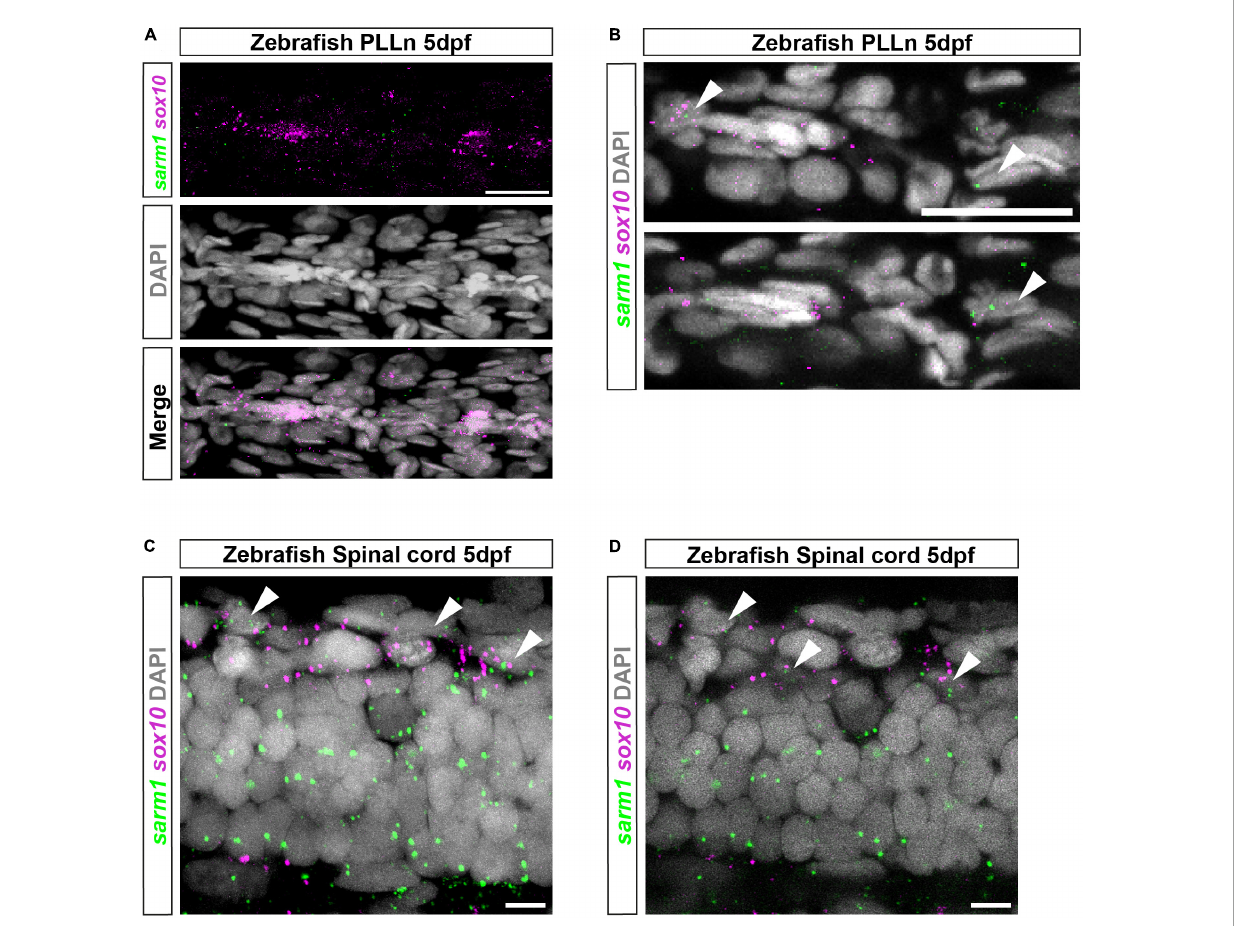
FIGURE2 sarm1 expression in zebrafish larvae PLLn and spinal cord. (A) MAX projection, lateral view of PLLn of a 5dpf larva demonstrating HCR in situ labeling for sox10 and sarm1 mRNA and DAPI staining to mark nuclei. (B) Single confocal z plane, 616 nm optical thickness, lateral view of PLLn of a 5dpf larva. Arrowheads mark nuclei, labeled with DAPI, positive for sox10 and sarm1 mRNA. In the PLLn, 22.4% ± 3.161 [mean and standard error of mean (SEM), n = 5 larvae, 5 sections per larvae] of sox10 positive cells also expressed sarm1 . (C) MAX projection, lateral view of spinal cord of a 5dpf larva demonstrating HCR in situ labeling for sox10 and sarm1 mRNA and DAPI staining to mark nuclei. Arrowheads mark nuclei positive for sox10 and sarm1 mRNA. (D) Single confocal z plane, 475 nm optical thickness, lateral view of spinal cord of a 5dpf larva. Arrowheads mark nuclei positive for sox10 and sarm1 mRNA. In the spinal cord, 60.3% ± 2.4 (mean and SEM, n = 5 larvae, 3 sections quantified per larvae) of sox10 positive cells also expressed sarm1. For all images: sox10 mRNA (magenta) and sarm1 mRNA (green), nuclei labeled with DAPI (gray), scale bar 25 µ m.